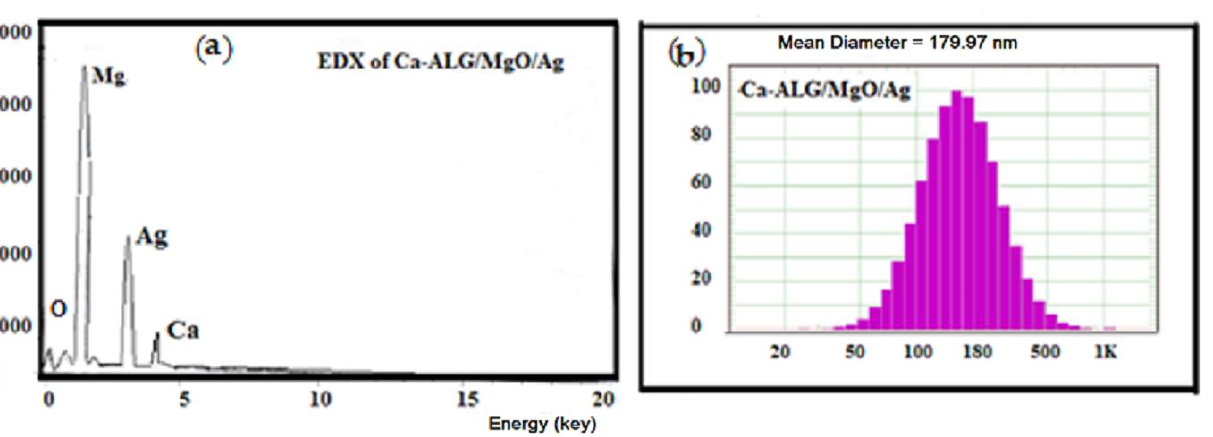
Figure 1. ( a ) EDX and ( b ) DLS diagrams of Ca-ALG/MgO/Ag nanocomposite beads